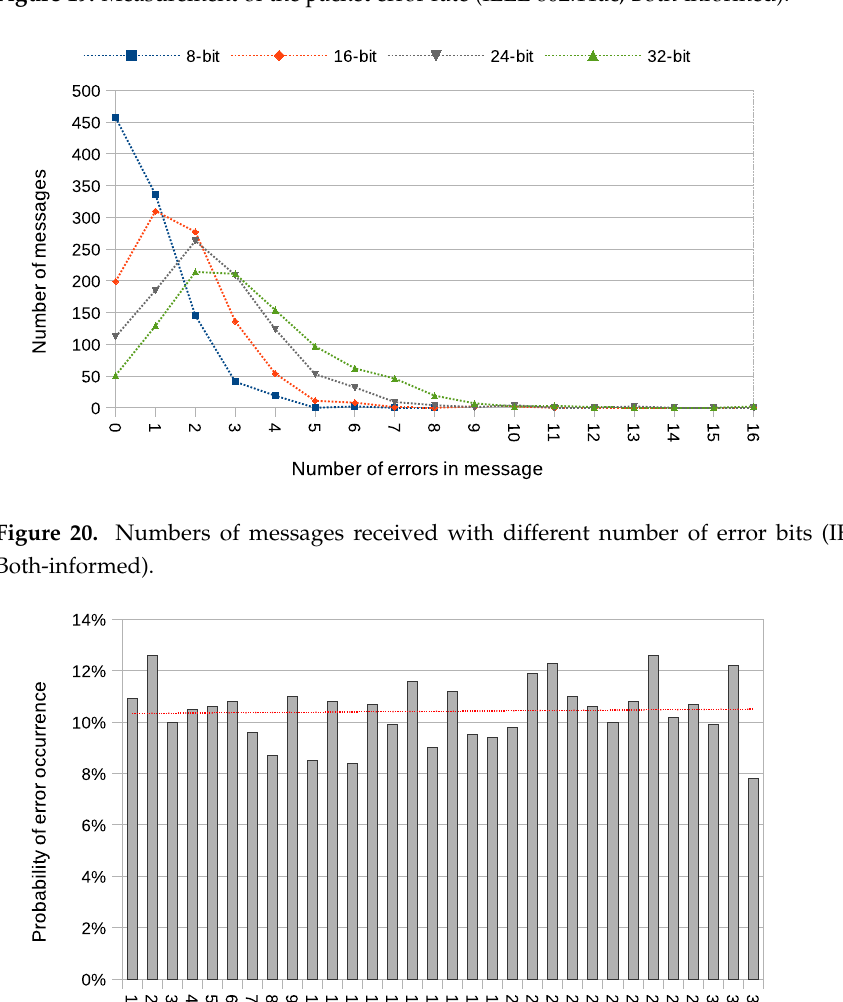
Figure 19. Measurement of the packet error rate (IEEE 802.11ac; Both-informed).